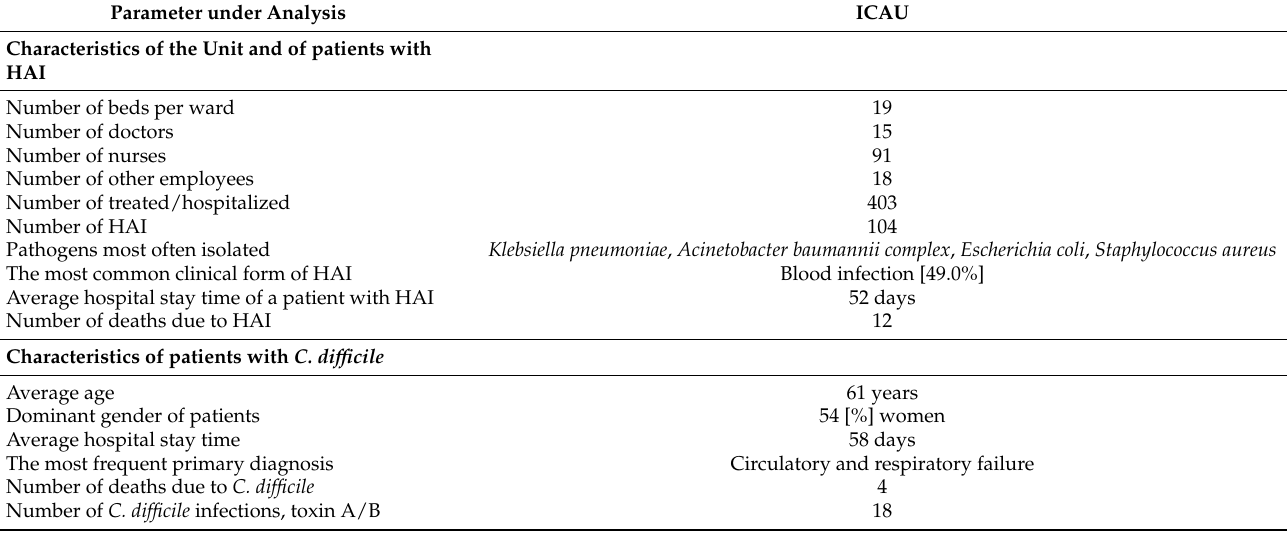
Table 7. Characteristics of the Intensive Care and Anesthesiology Unit and patients with HAI and with C. difficile infection in